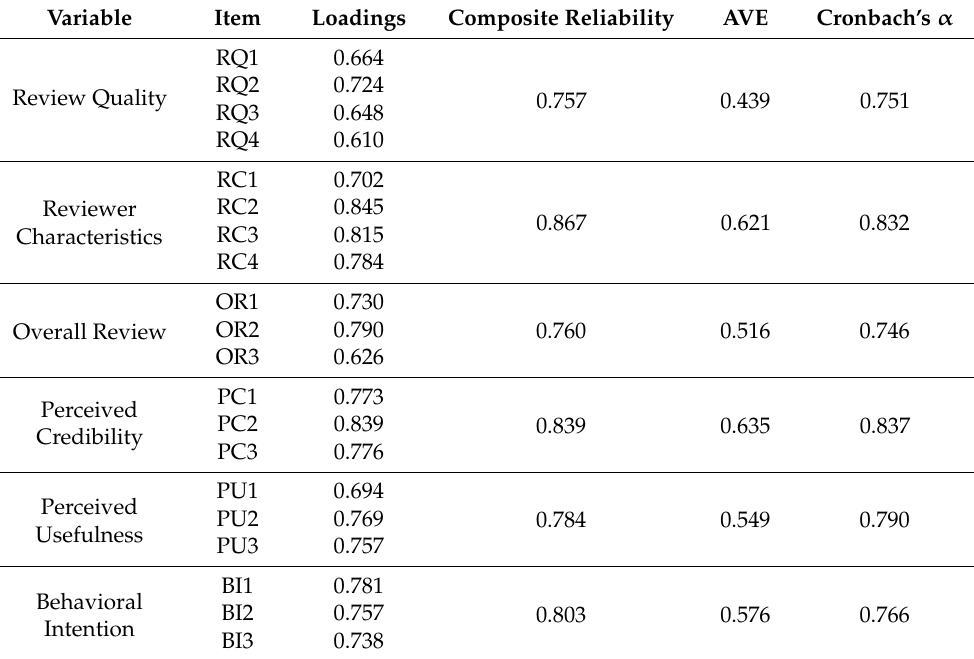
Table 3. Summary of confirmatory factor analysis and reliability analysis.